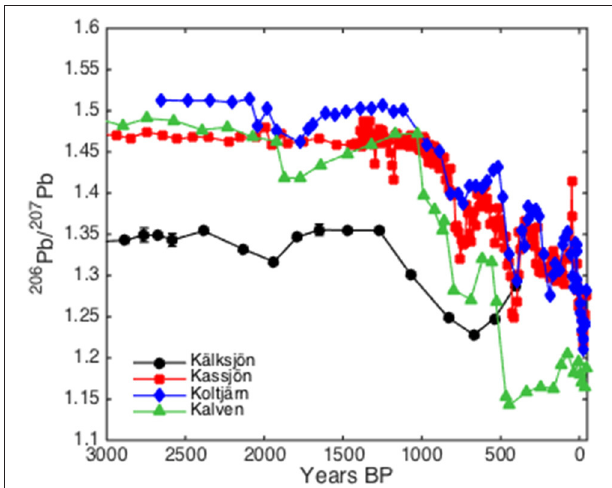
FIGURE 5 | Kälksjön lead isotope 206 Pb/ 207 Pb ratio plotted against the age-depth curve based on paleomagnetic data (solid symbols) with linear interpolation between data points. For comparison the 206 Pb/ 207 Pb ratio for similar independently dated records from Kassjön, Koltjärn, and Kalven are also